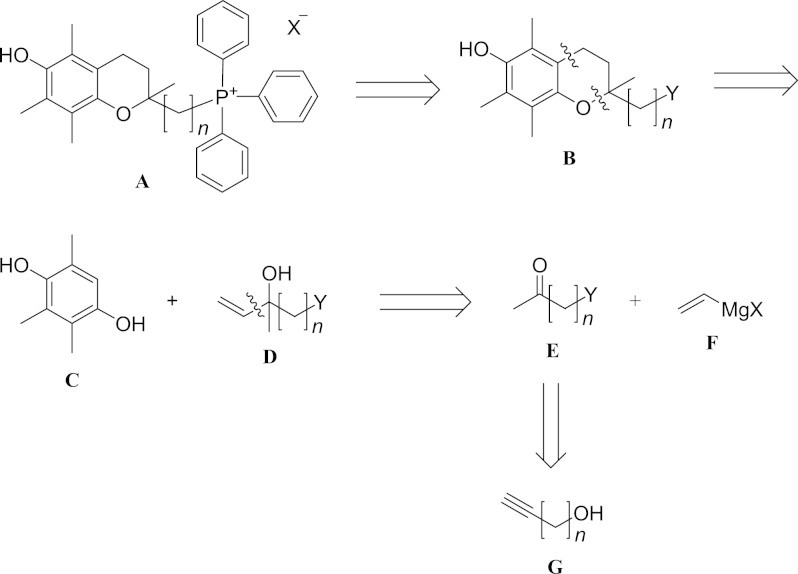
Retrosynthetic analysis of MitoEn.